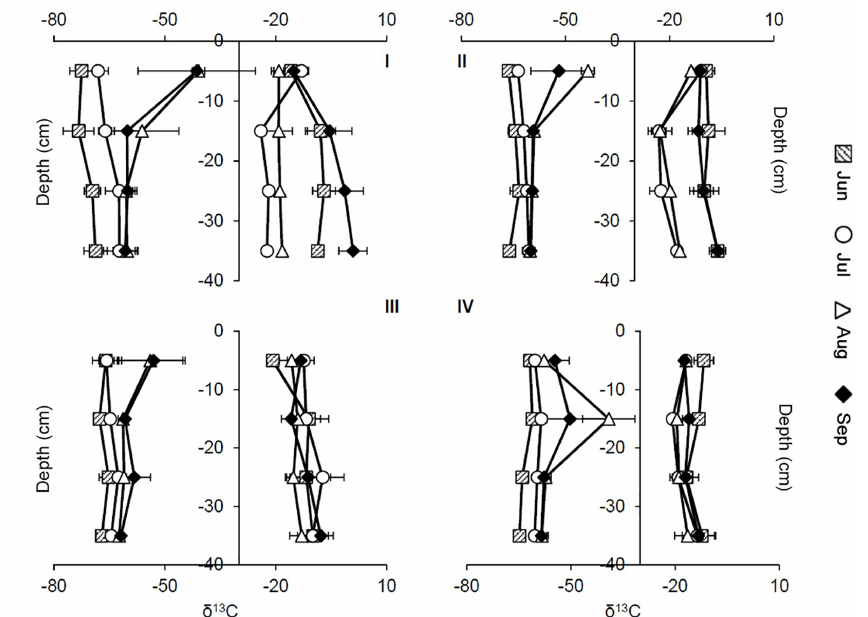
Figure 5. Profiles of δ 13 C–CH 4 (left side) and δ 13 C–CO 2 (right side) signatures at sites 1–4 in the peat in 5–35cm of depth at different points in time. Squares: June (11 June), circles: July (8 July), triangles: August (27 August), diamonds: September (17 September). Graphs show mean values and SDs from three replications at each site ( n =